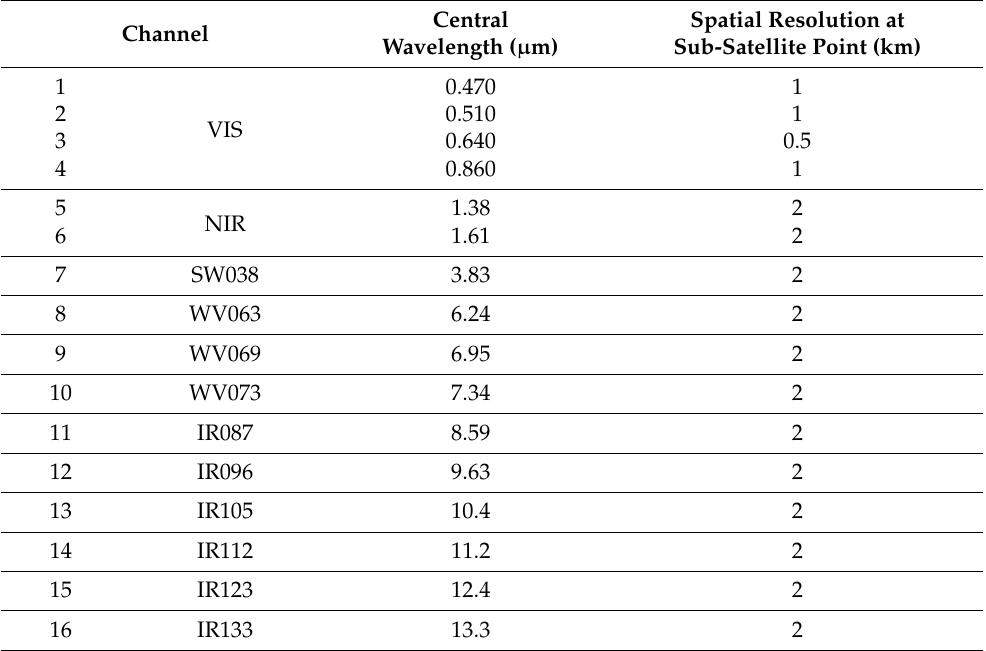
Table 1. GEO-KOMPSAT-2A Advanced Meteorological Imager